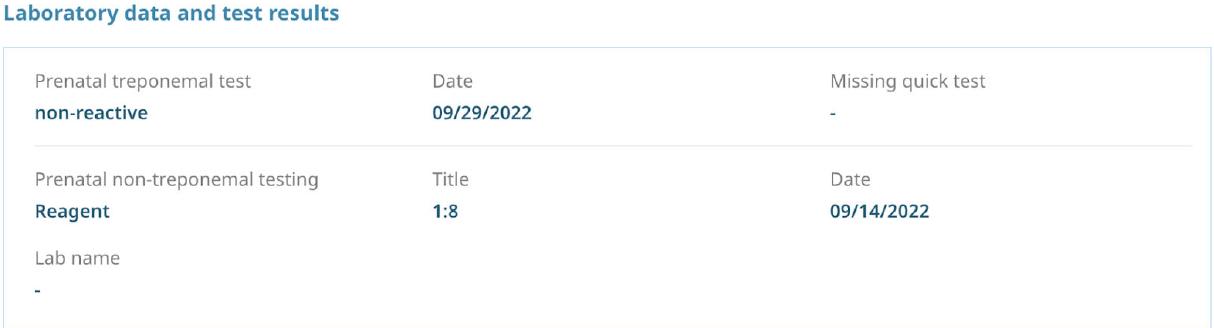
Figure A8. Exam results. Figure A8. Exam